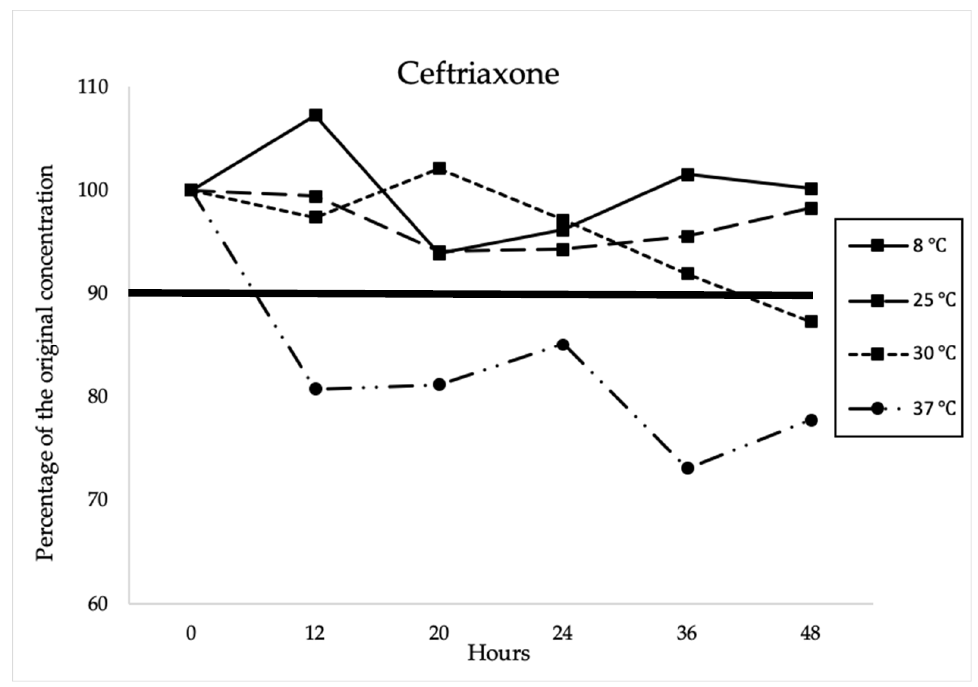
Figure 2. CRO stability expressed as mean percentage of original concentration over time at 8 °C ± 2 °C, 25 °C ± 2 °C, 30 °C ± 2 °C and 37 °C ± 2 °C. Dashed line indicates 90% of residual